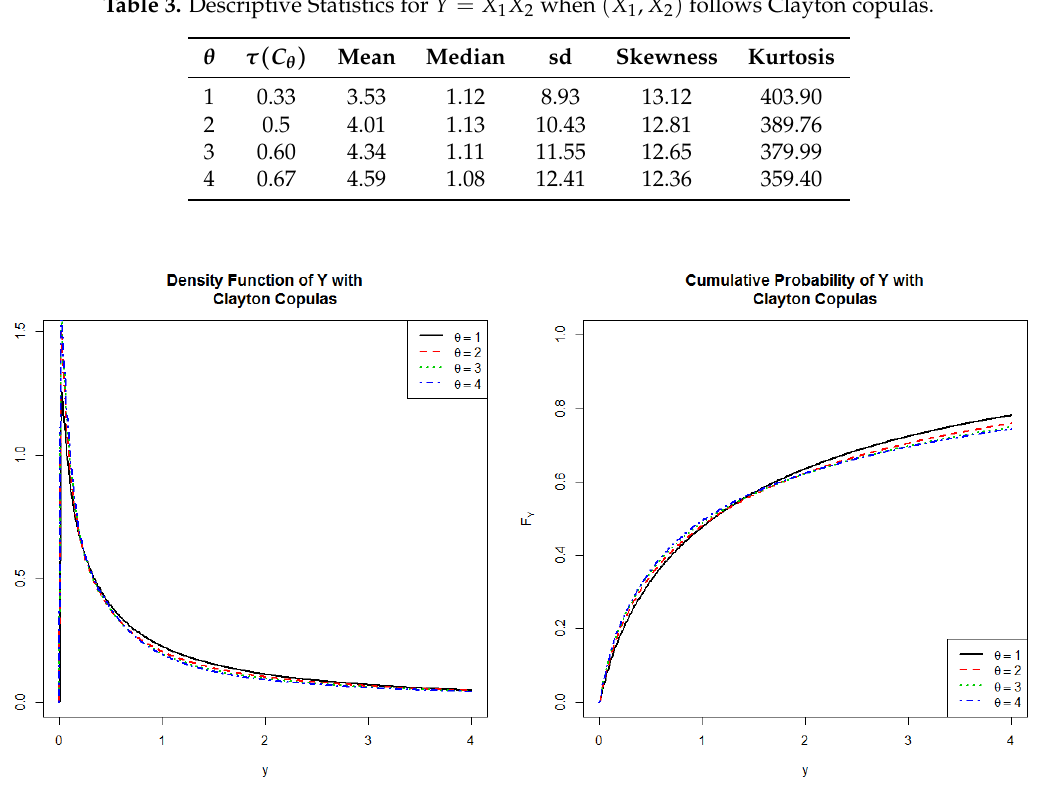
Figure 3. PDFs and CDFs of the product of two log-normal distributed random variables having Clayton